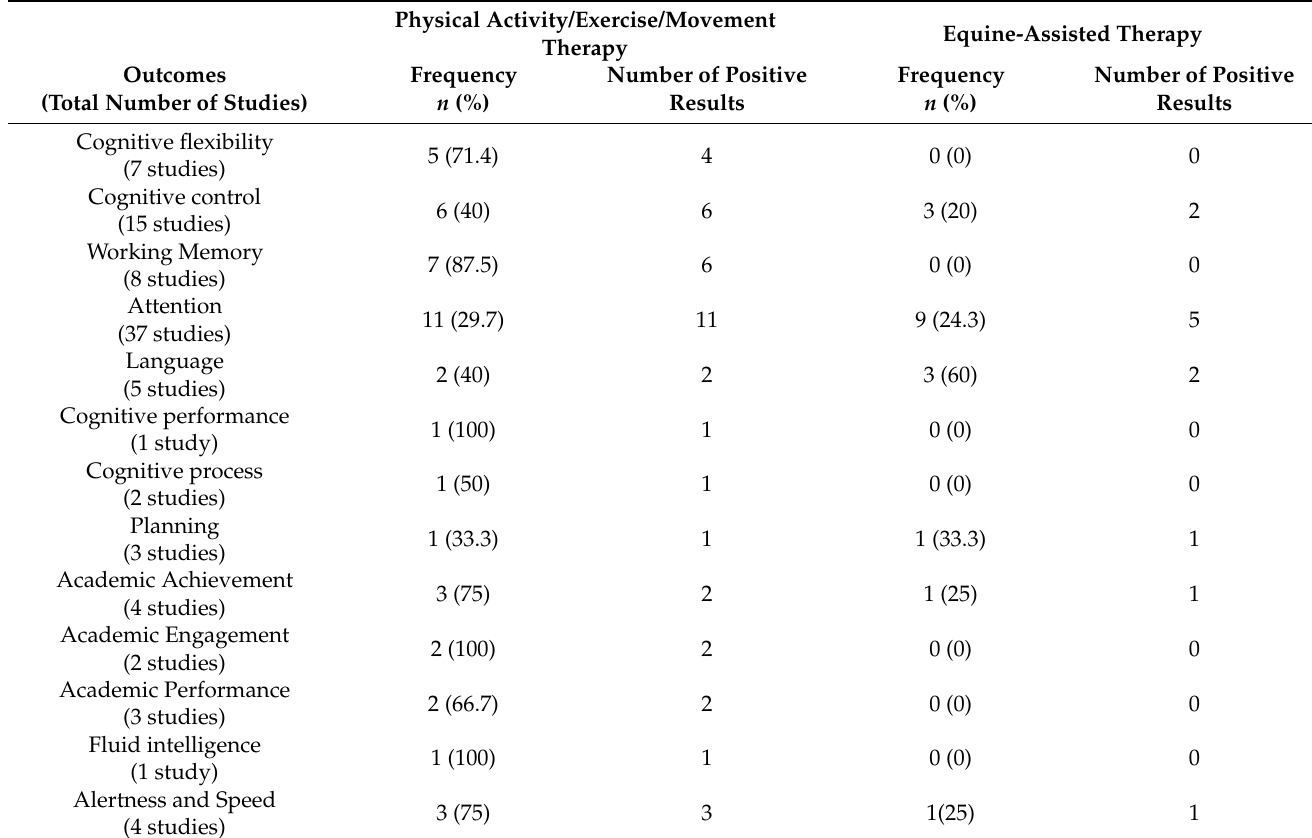
Table 4. Frequency of cognitive outcomes assessed for the two most common physical activity interventions and the direction of